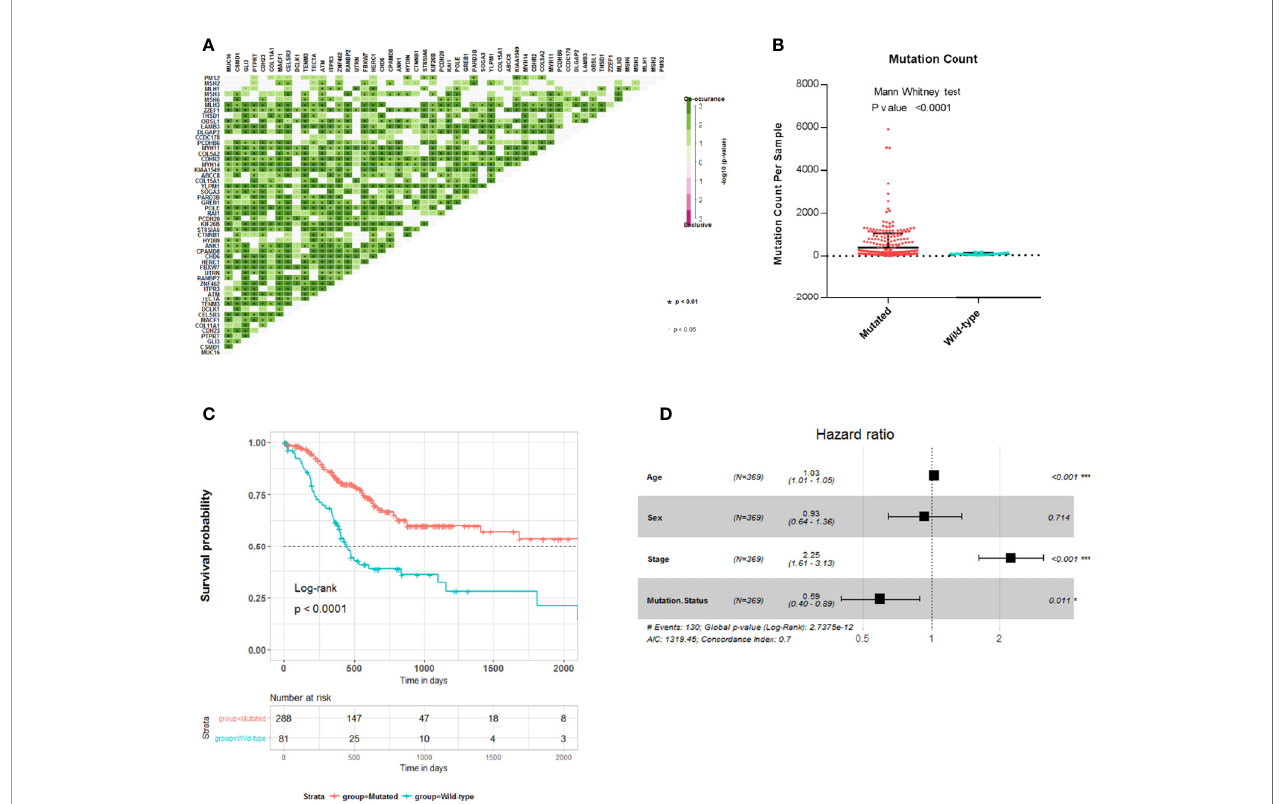
FIGURE 2 | Association of 45 mutated genes status with tumor mutation load and prognosis in The Cancer Genome Atlas (TCGA) Stomach Adenocarcinoma (STAD) cohort. (A) Mutually exclusive and co-occurring gene pairs in STAD displayed as a triangular matrix. Green indicates tendency toward co-occurrence, whereas pink indicates tendency toward exclusiveness. (B) Mutation count per sample of gastric adenocarcinoma strati fi ed by 45 mutated genes status. (C) Kaplan – Meier survival analysis strati fi ed by 45 mutated genes status. (D) Multivariable Cox regression model tests for age, sex, TNM stage, and 45 mutated genes status. Square data markers indicate estimated HRs. Error bars represent 95% CIs. *p < 0.05; **p < 0.01; ***p < 0.001.